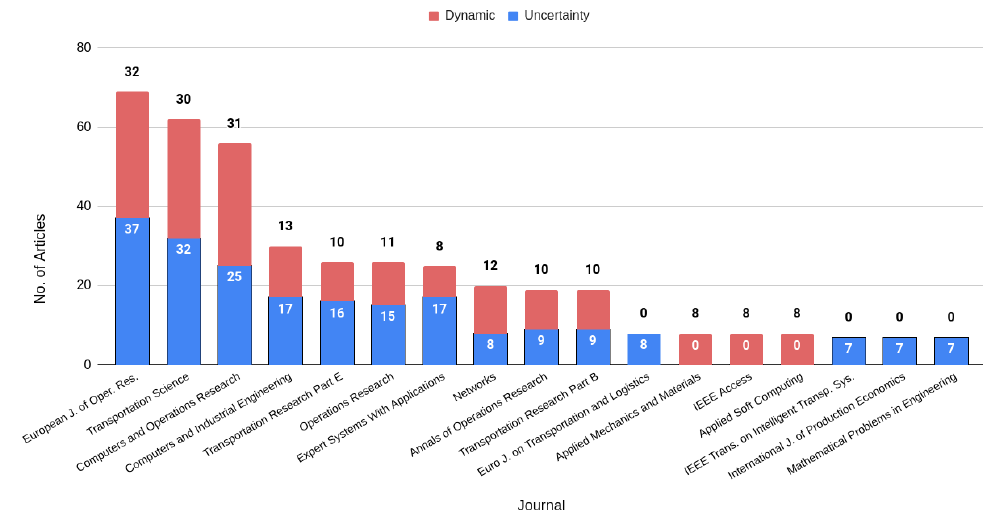
Figure 2. List of journals that published articles on VRPs under uncertainty or in dynamic